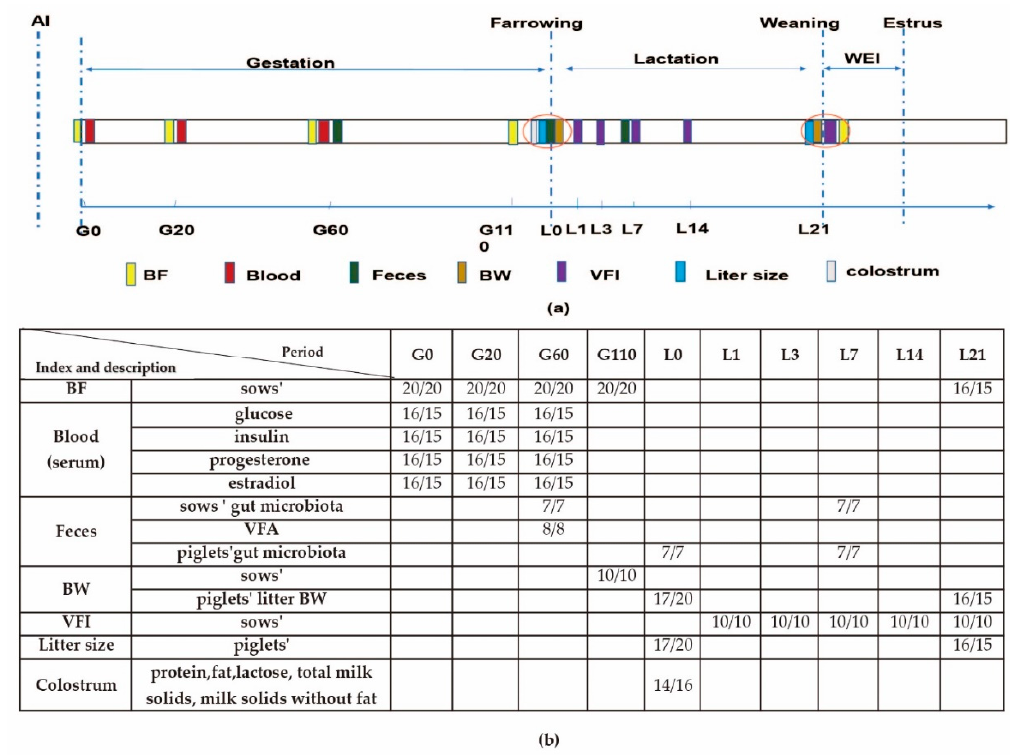
Figure 1. Timeline, numbers of different samples, and indices for sows and their piglets from both treatment groups during the gestation and lactation periods. G0, G20, G60, and G110 indicate gestation days 0, 20, 60, and 80, respectively. Similarly, L0, L1, L3, L7, L14, and L21 represent lactation days 0, 1, 3, 7, 14, and 21, respectively. BF = backfat; BW = bodyweight; VFI = voluntary feed intake. The numbers of each sample are shown as n CON /n FFM